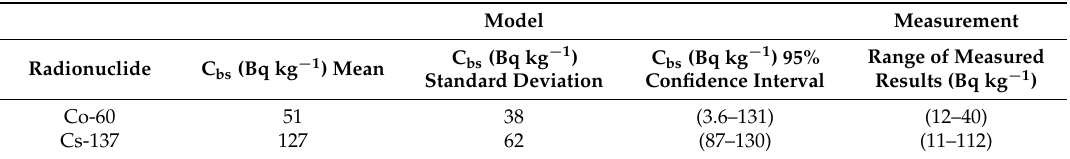
Table 2. Modelled results of radionuclide concentrations in bottom sediments (Cbs) due to Almaraz NPP’s liquid releases and range of reported measurement values (CSN, 2006) [12].